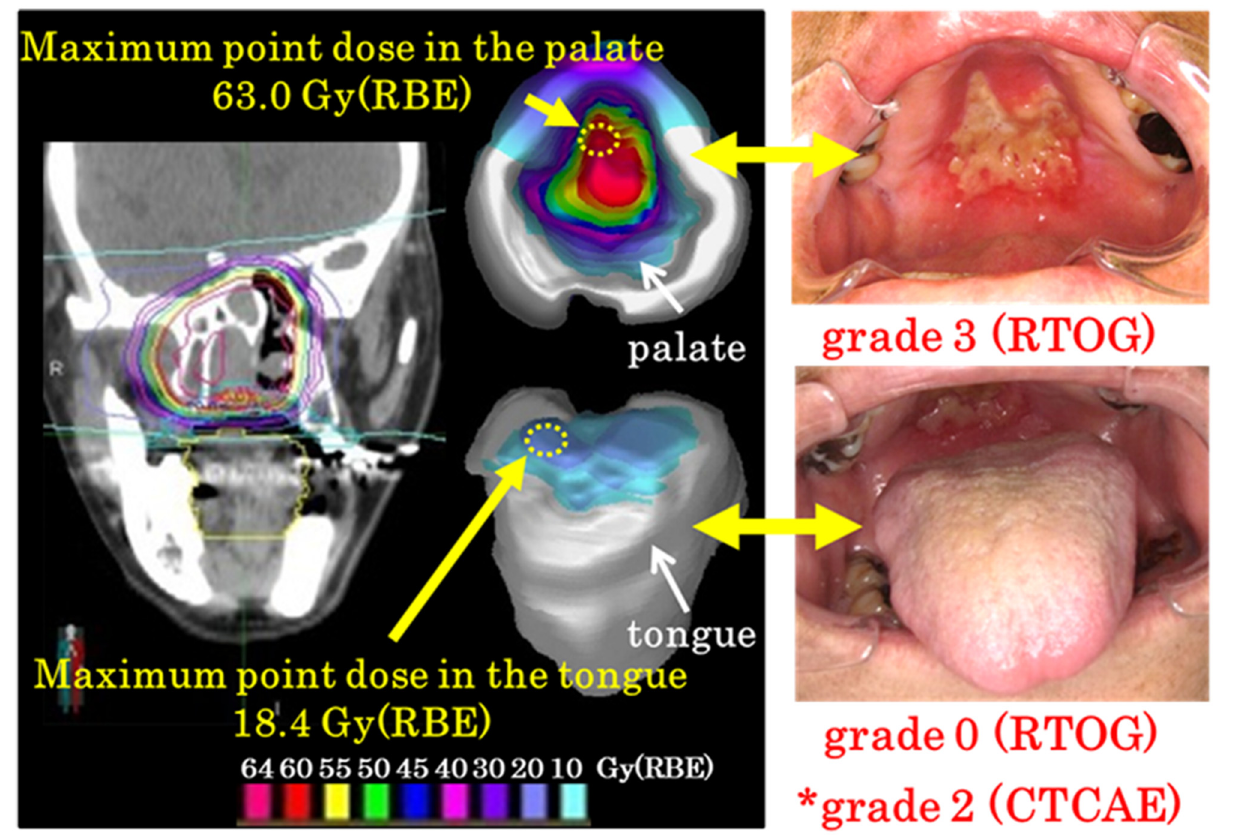
Fig 1. Oral mucosal dose surface model and corresponding mucositis. Representative dose distributions (coronal image, palate, and tongue surface) in a patient with malignant melanoma of the right nasal cavity are shown. The location of the acute radiation mucositis (ARM) approximated the high radiation dose area. ARM was classified as grade 2 according to version 4 of the Common Terminology Criteria for Adverse Events (CTCAE) * and as grade 3 (palate) and grade 0 (tongue) according to the Radiation Therapy Oncology Group (RTOG) criteria. RBE, relative biological effectiveness.